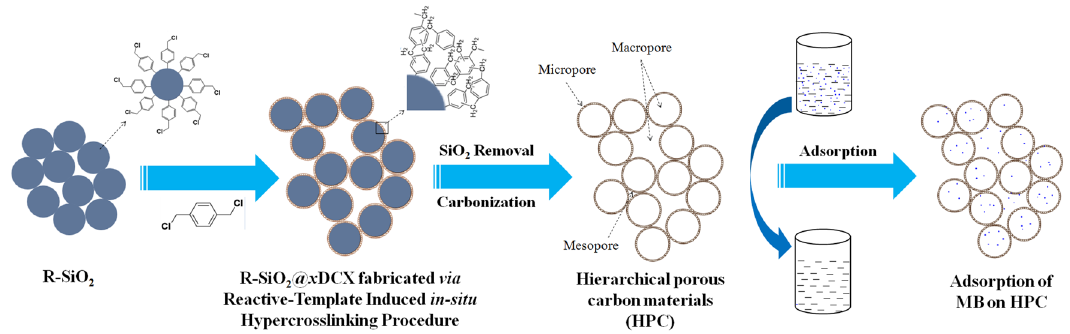
Figure 1. Schematic of novel hierarchical porous carbon material (HPC) and methylene blue (MB)